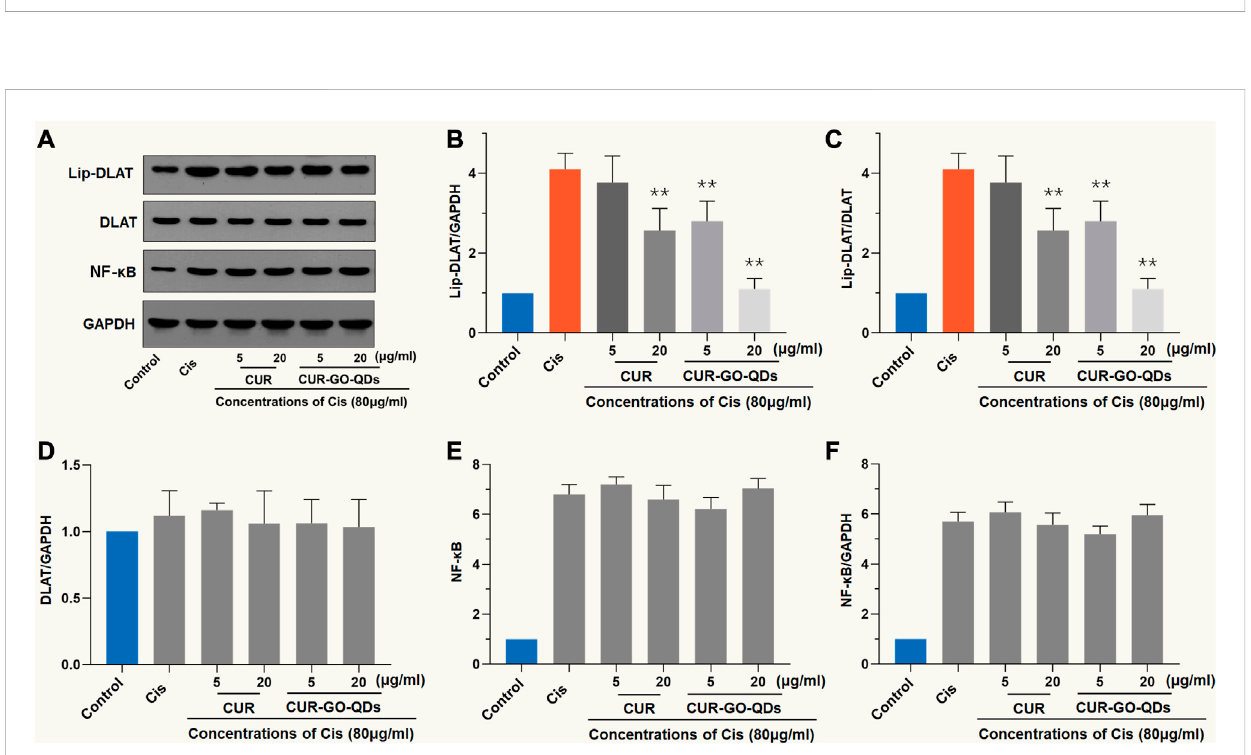
FIGURE 5 Western blotanalysiswithDLAT. (A) OC1cellsweretreatedwithCISandCURorCUR/GOQDs asdescribedabove.DetectionofDLATexpressionby WB. (B – D) The light intensity of protein expression was quanti fi ed according to the above WB results. The application of CUR or CUR/GOQDs in OC1 treated with CIS resulted in a decrease in the ratio of Lip-DLAT/GAPDH (B) and Lip-DLAT (C) , while the ratio of DLAT (D) , NF- κ B (E) and NF- κ B/ GAPDH (F) did not change. ** p < 0.01, as compared to